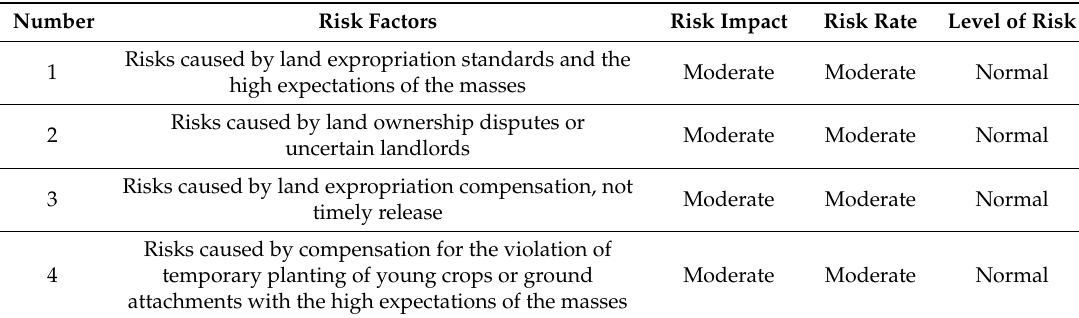
Table 3. Main risk assessment of the